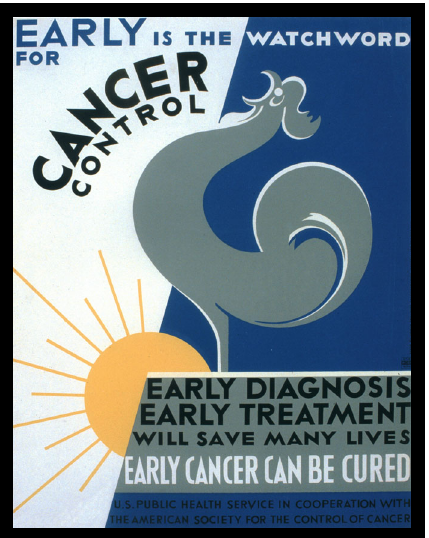
Figure 1. A promotional poster by the US Public Health Service in cooperation with the American Society for Control of Cancer dated